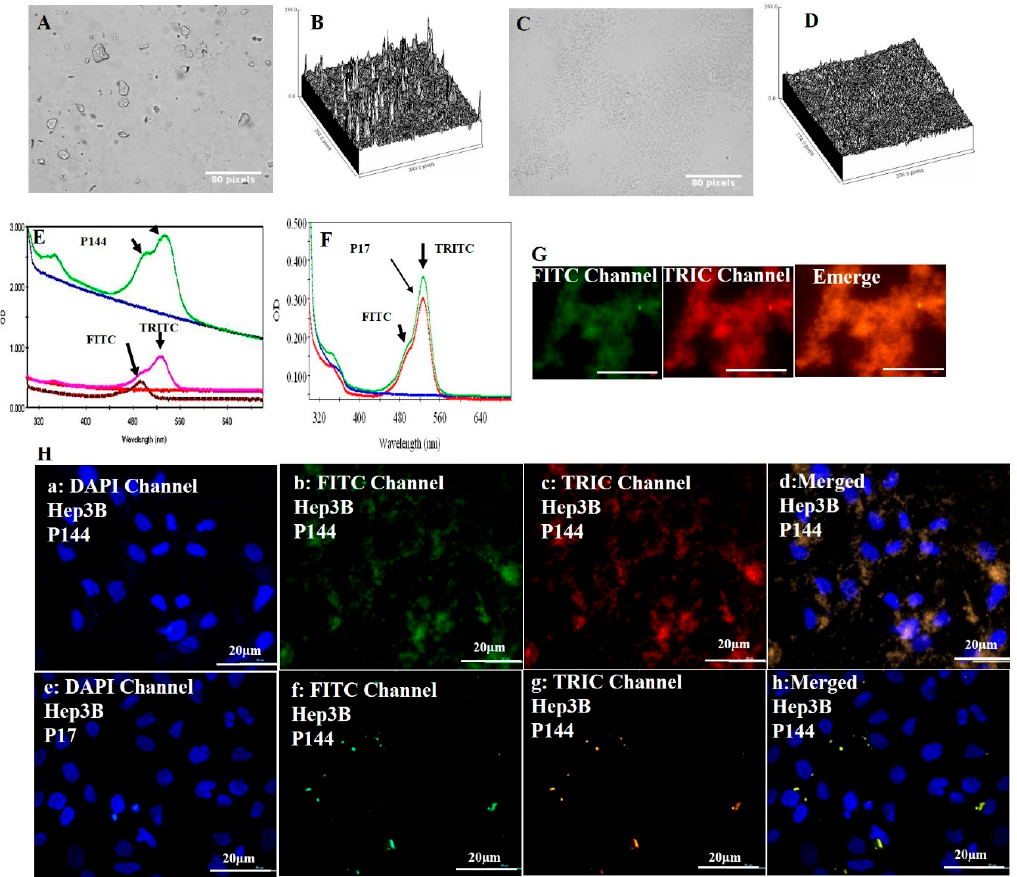
Figure 1. Optical microscopic image of P144 dissolution. ( A ) P144 dissolved by DMSO; ( B ) ImageJ analysis of P144 dissolved by DMSO; ( C ) P144 dissolved by sonication; ( D ) ImageJ analysis of sonicated P144; ( E ) rhodamine-labeled peptide P144; ( F ) rhodamine-labeled peptide P17; ( G ) fluorescence microscopy for images labeled P144. ( H ; a – d ) Cellular uptake of sonicated P144; (E–H) Cellular uptake of suspended P17.